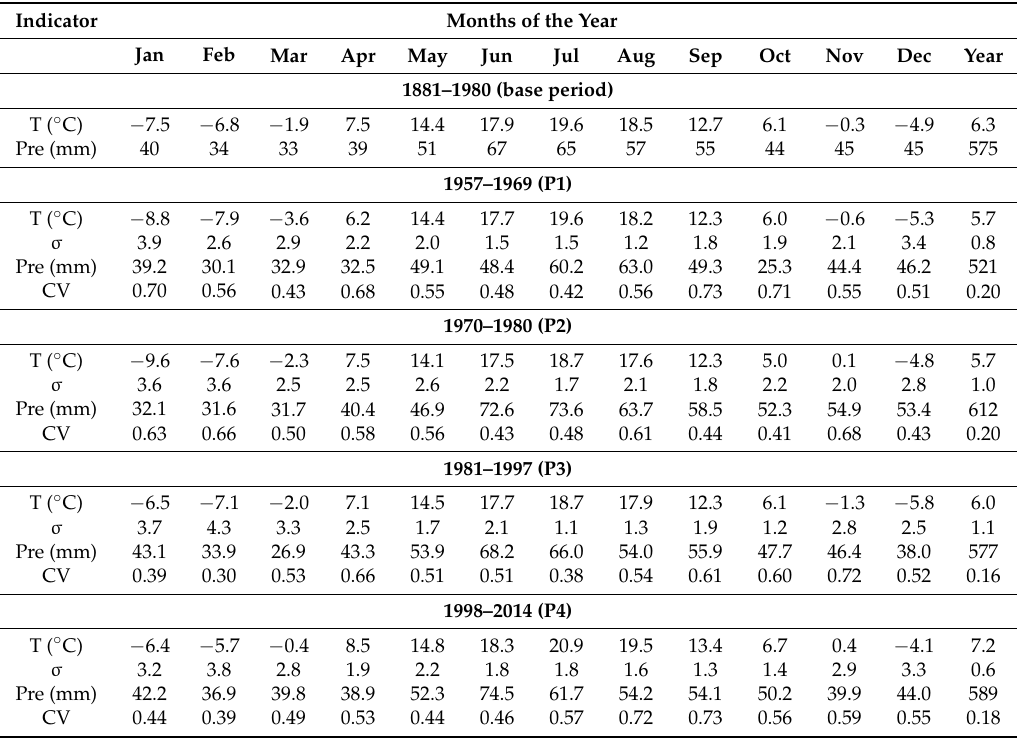
Table A1. Temperature ( ◦ C), precipitation (mm) and their anomalies and CV (2) over periods defined in Table 2 during the current epoch [4] as defined for the study region using the BELF surface